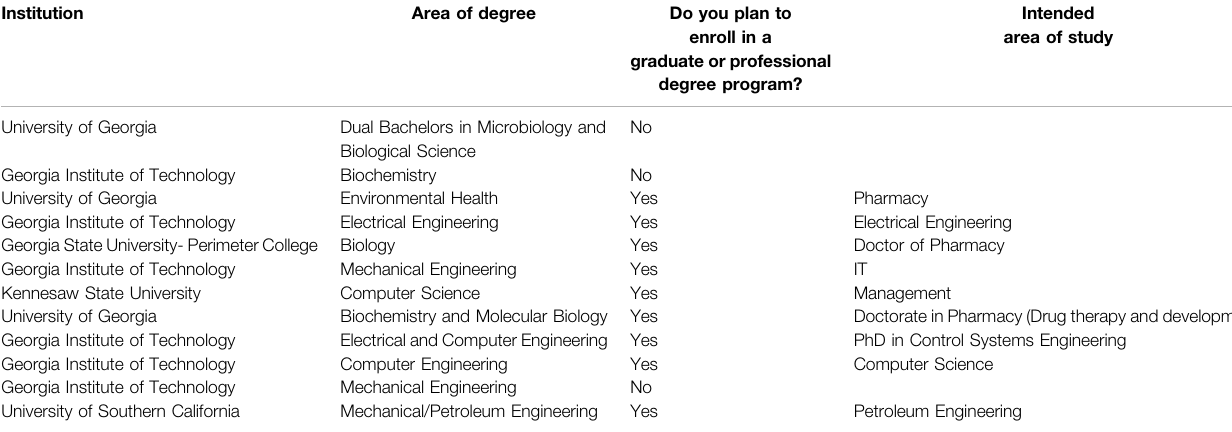
TABLE 6 | Information from transfer bridge program alumni who graduated and are not currently enrolled in higher education.